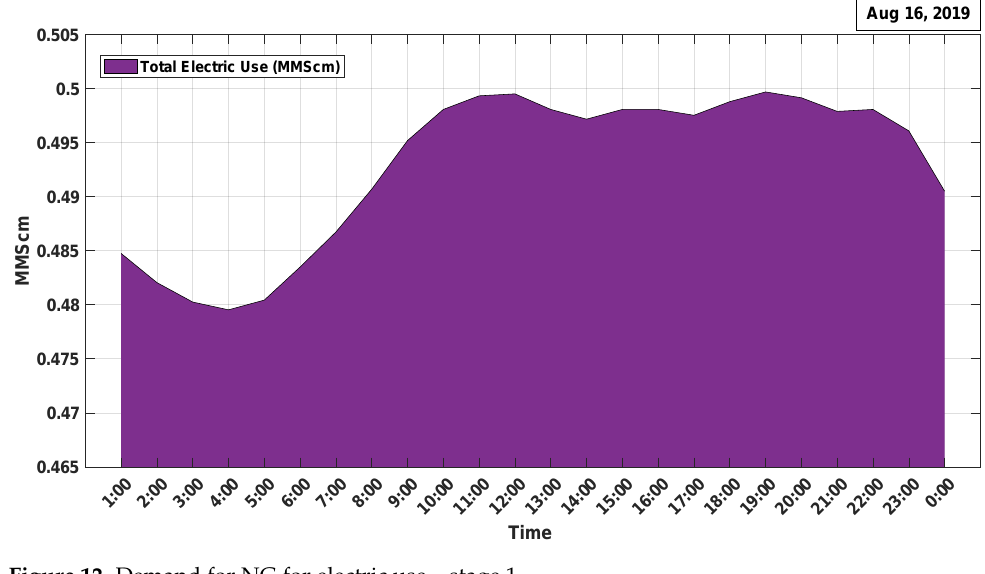
Figure 12. Demand for NG for electric use—stage 1.